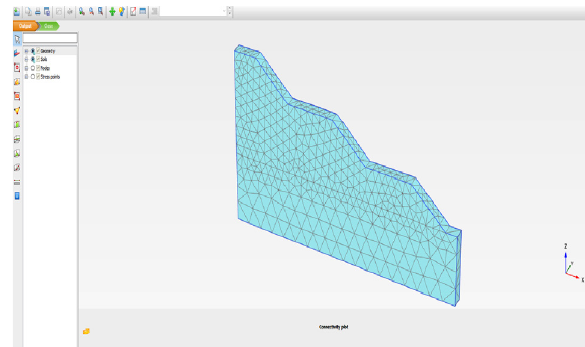
Figure 5. Comparison of UCS values of contaminated and